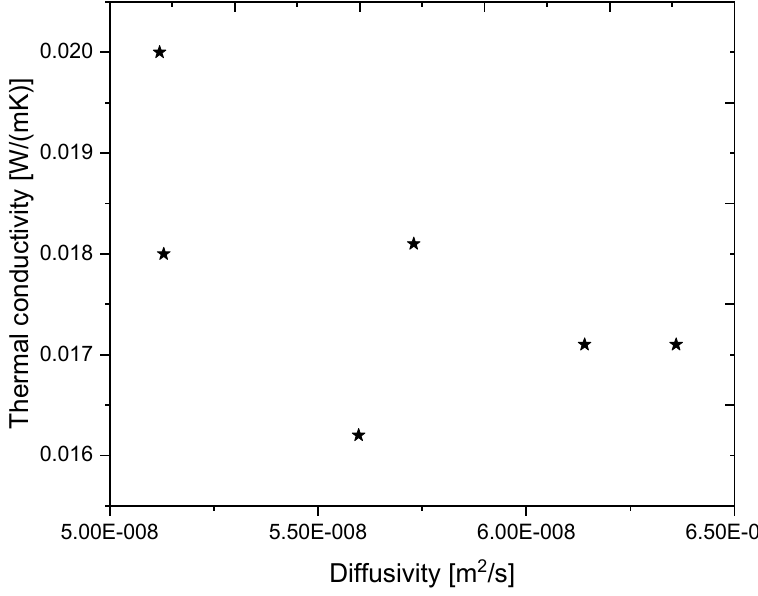
Figure 1. Thermal diffusivity versus thermal conductivity .